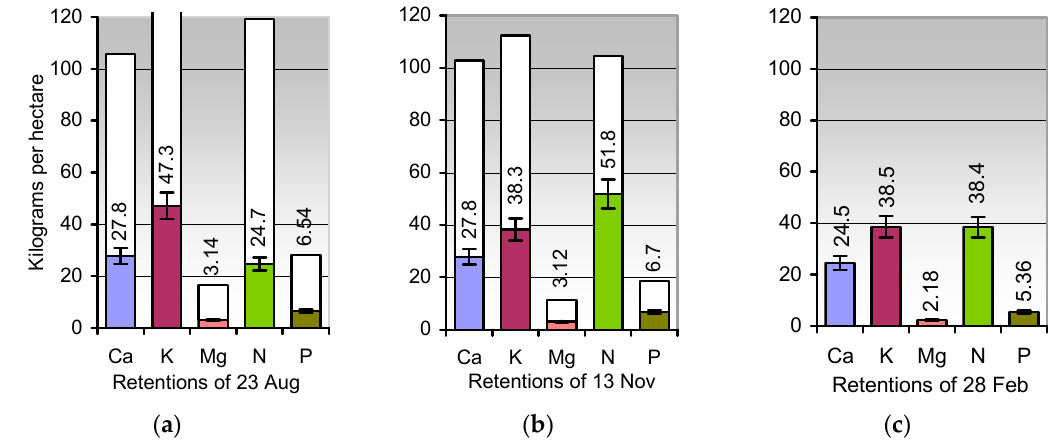
Figure 3. Goldenrod: The cropland retention of the minerals (kg ha − 1 , figures heading the columns) both in dry 16-cm stubbles and roots during blooming (23 August, ( a )), maturity (13 November, ( b )), and resprouting (28 February, ( c )). White column segments indicate the sums of minerals in shoots and roots prior to harvest (K, 178 kg ha − 1 on 23 August). All columns refer to the zero axis. See Table 2 for details. Error bars indicate ± SD. NPK stock in stubbles/roots from 23 August to 28 February (kg ha − 1 ): 78.5, 96.8, 82.3.